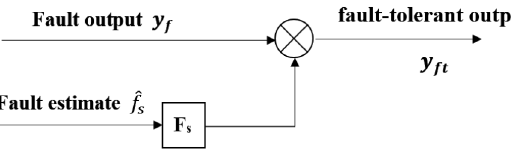
Figure 7 Schematic diagram of